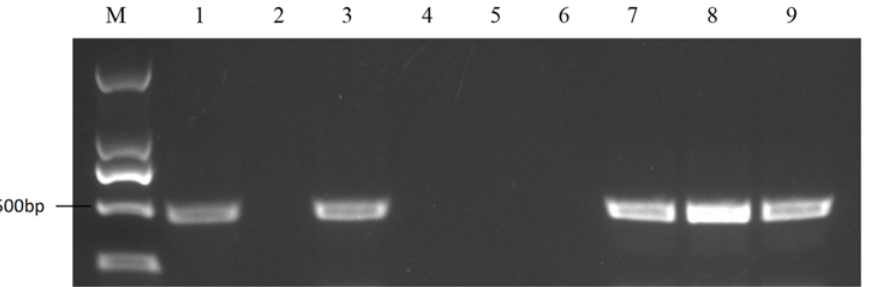
Figure 4. PCR amplification of PKC6F/PKC6R in 18-512 sister lines. M represents the DNA Marker 2000; 1 represents the positive control; and 2 represents the negative control. Lanes 3–9 are 18-512, 18-2169-1, 18-2169-2, 18-2169-3, 18-2170-1, 18-2170-2, and